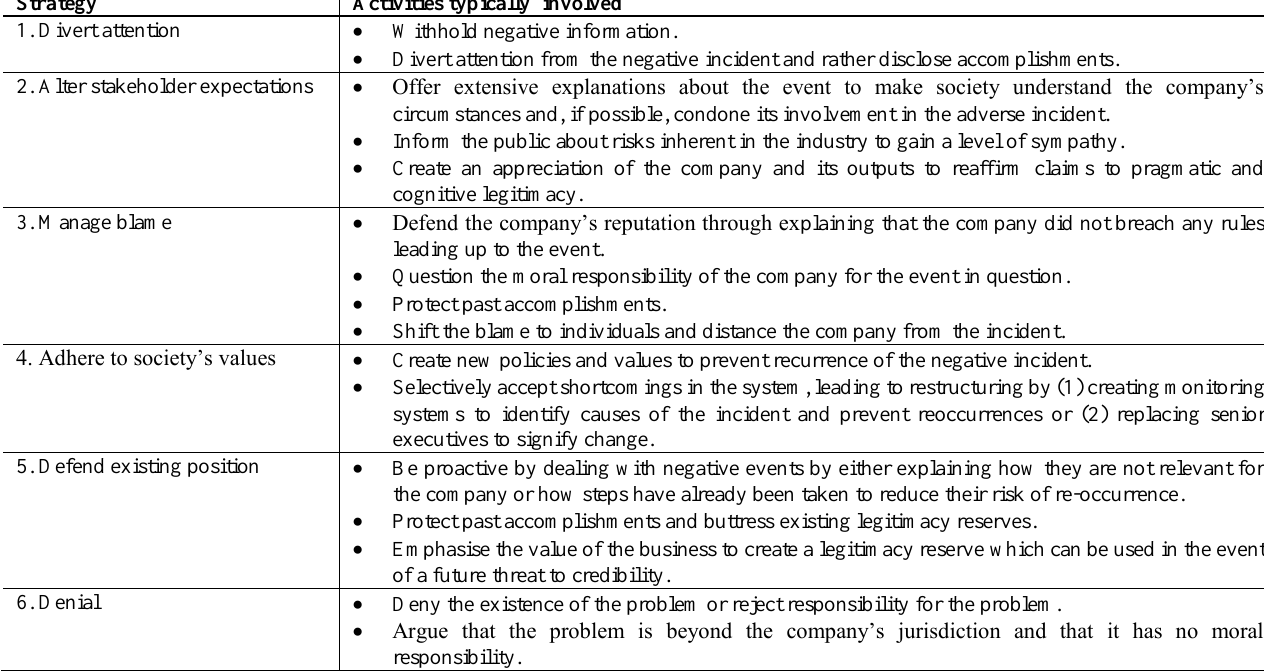
Table 1: Strategies for maintaining and repairing legitimacy Strategy Activities typically